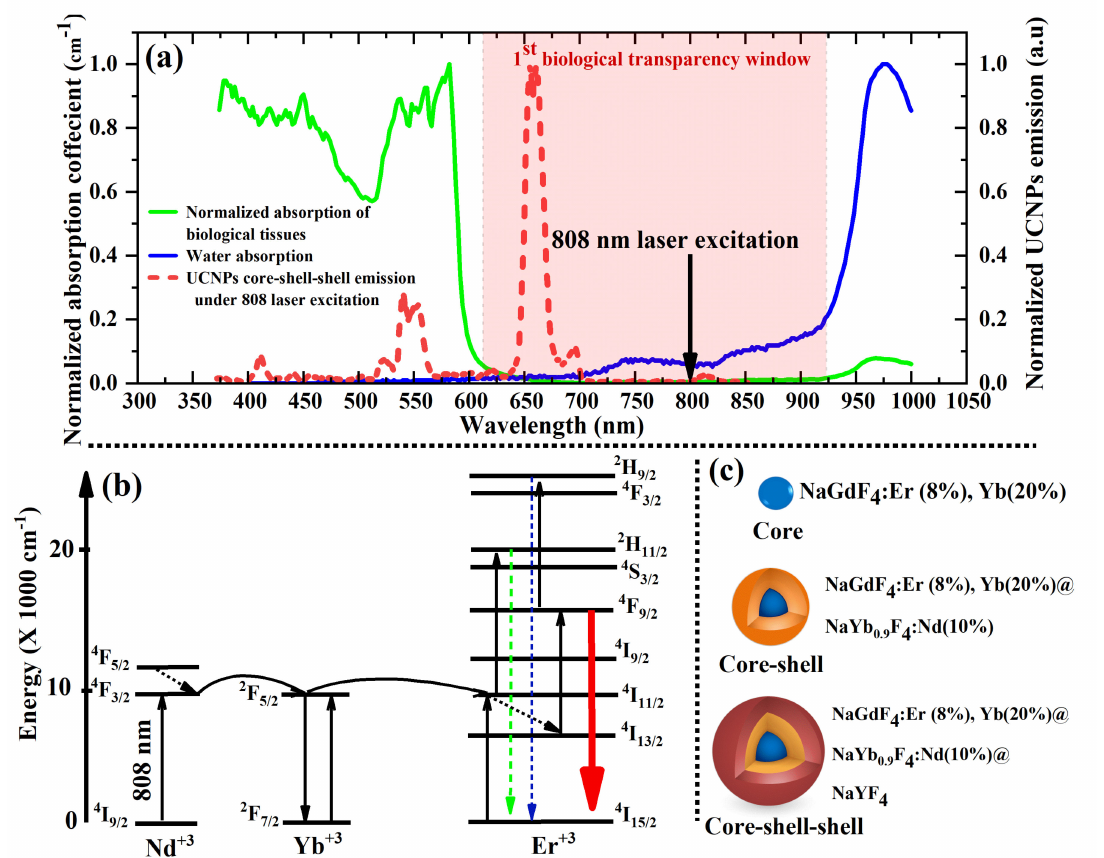
Figure 1. ( a ) Illustration of a superimposed photoluminescence of red enhanced emission of the synthesized CSS UCNPs under 808 nm continuous laser excitation, the illumination and absorption spectra of distilled water (DI water), and biological tissue taken over the visible and the near-infrared (NIR) range. (Data presented in Figure 1a were experimentally collected for this present study). ( b ) Electronics structure and energy transfer processes among Nd +3 , Yb +3 , and Er +3 of red enhanced CSS UCNPs (photon upconversion) under 808 nm laser excitation. ( c ) An overview of the synthesized UCNP architectures and doping ratio at each